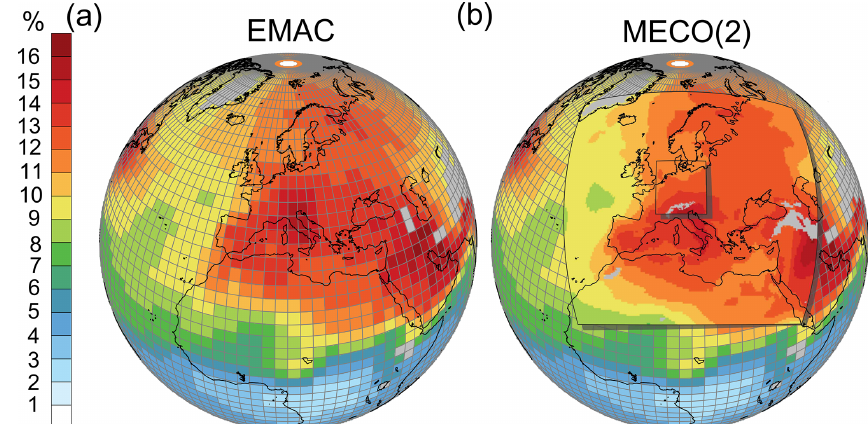
Figure 2. Relative contribution (in percent) of land transport emissions to the ozone column up to 850hPa, averaged over July 2008. (a) The values calculated by the EMAC model and (b) the values calculated by MECO(2) with the two refinements covering Europe and